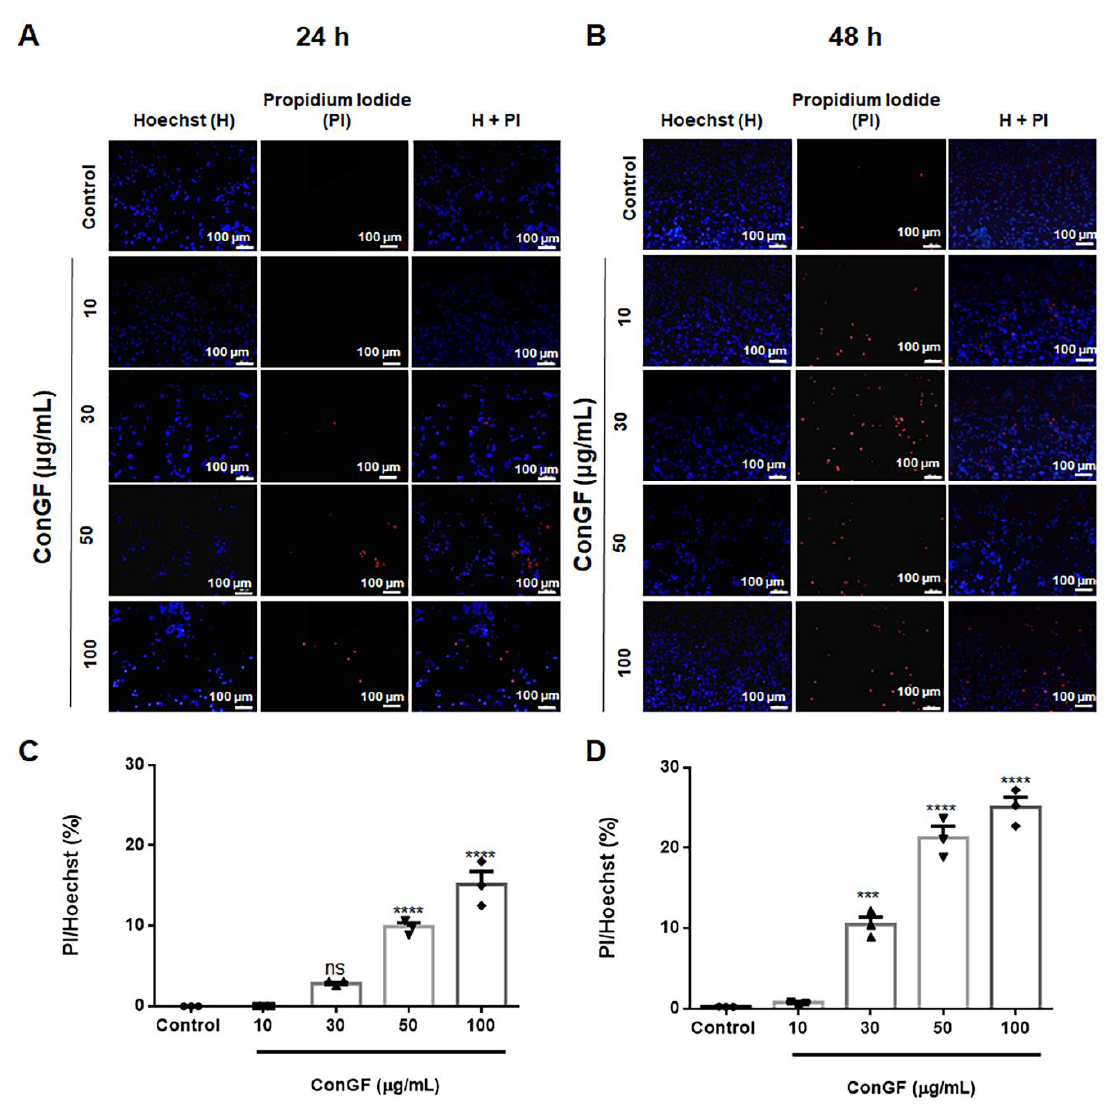
Figure 3. Evaluation of C6 glioma cell membrane injury in response to ConGF treatment. C6 glioma cells were incubated with vehicle (control) or ConGF (10, 30, 50, or 100 µ g/mL) for 24 or 48 h. The cells were stained with Hoechst and propidium iodide (PI). ( A , B ) are representative images of Hoechst and PI staining in response to ConGF treatment for 24 and 48 h, respectively. ( C , D ) Quantification of PI staining in response to ConGF treatment for 24 and 48 h, respectively. Data were expressed as a percentage and the values are presented as mean ± SEM. (The scale bar represents 100 µ m). For all analyses, four independent experiments were performed. One-way ANOVA followed by the Bonferroni post-hoc test. *** p < 0.001 and **** p < 0.0001, as compared to control. ns = no